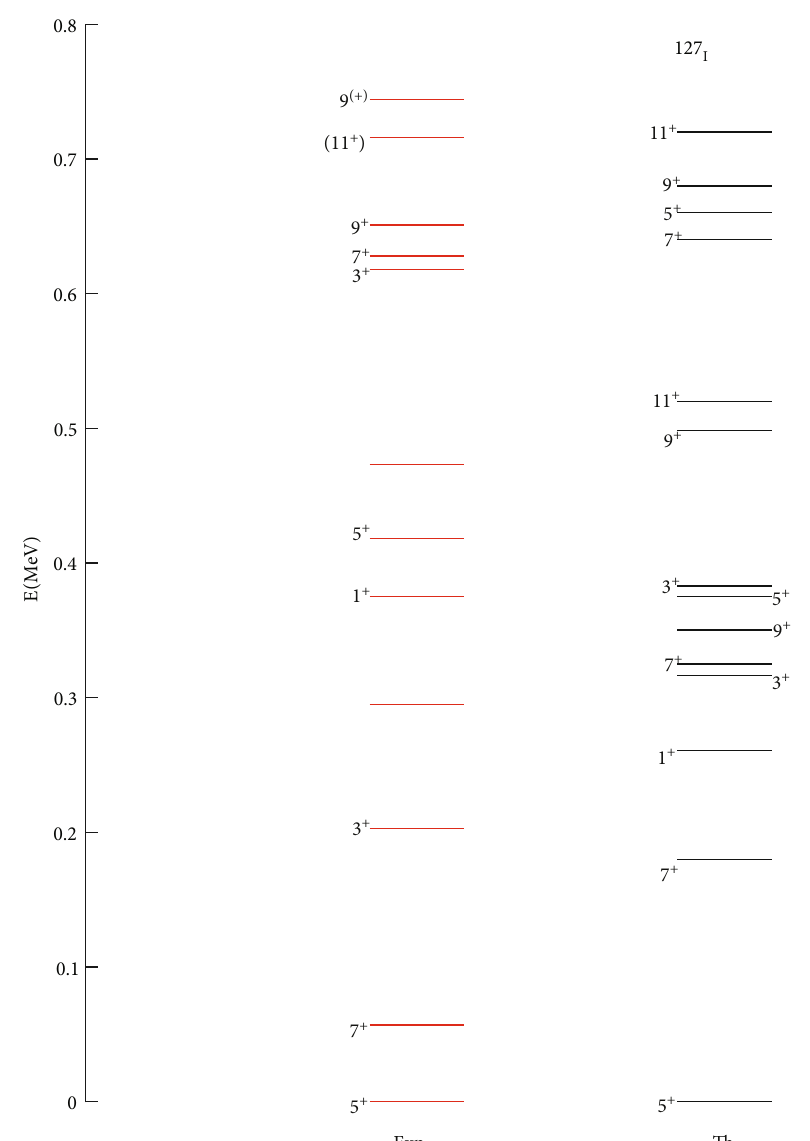
Figure 3: The low-lying experimental (a) [62] and theoretical (b) energy spectrum of 127 I. The levels in the fi gure are labeled by 2 J . Note that the spin and parity of the experimental states at 0.295 MeV and 0.473MeV are not